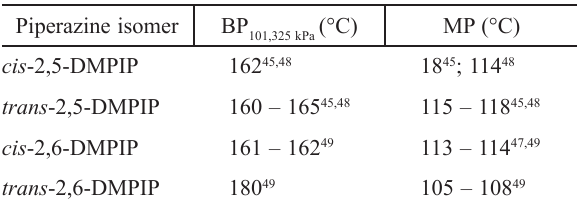
Table 2 – Boiling point (BP) and melting point (MP) of dias- tereoisomers cis/trans 2,5- and 2,6-DMPIP Piperazine